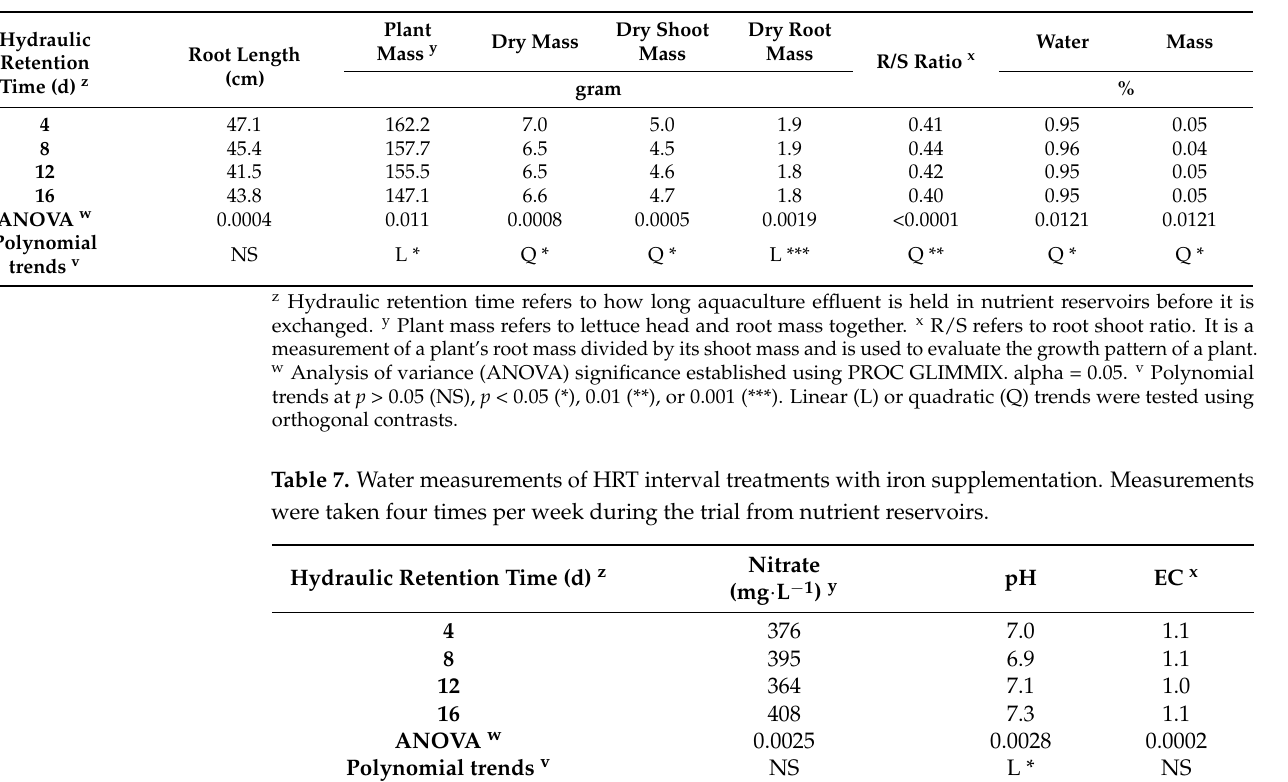
Table 6. Final plant measurement analysis of ‘Rex’ butterhead lettuce ( Lactuca sativa ) HRT with iron supplementation.